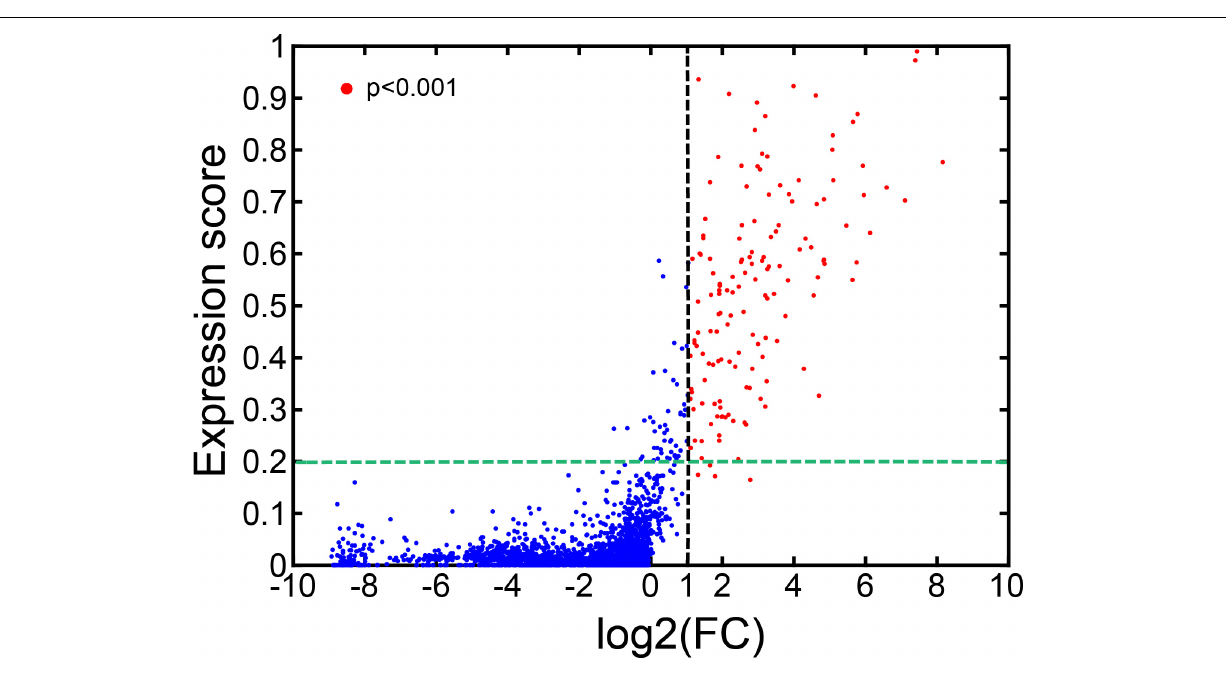
different organs. Bulk RNA-Seq profiles from 17 organs